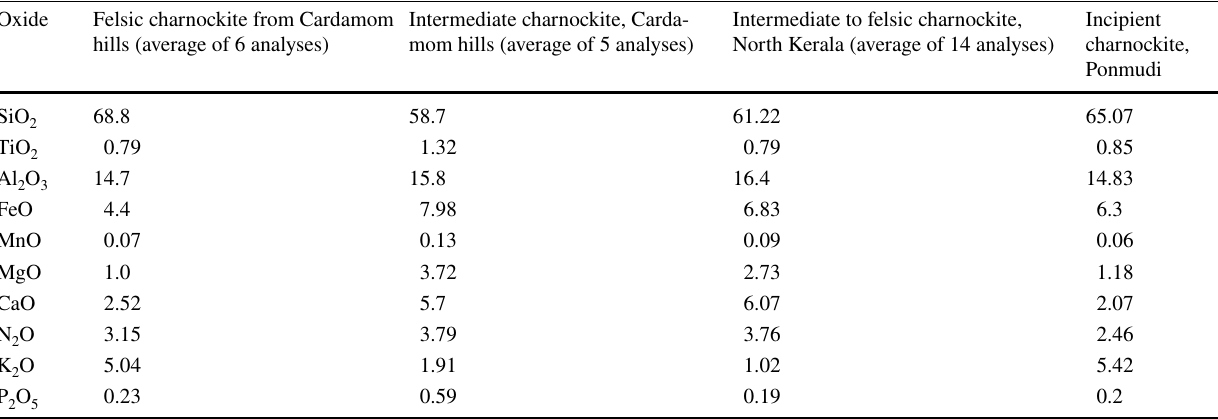
Table 1 Chemical composition of charnockites from Kerala (wt%) (Soman 2002) Oxide Felsic charnockite from Cardamom hills (average of 6 analyses)